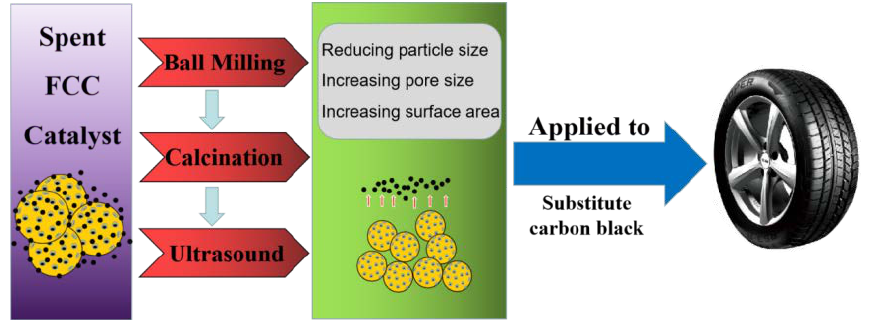
Figure 1. Flow chart of spent FCC catalyst modification.